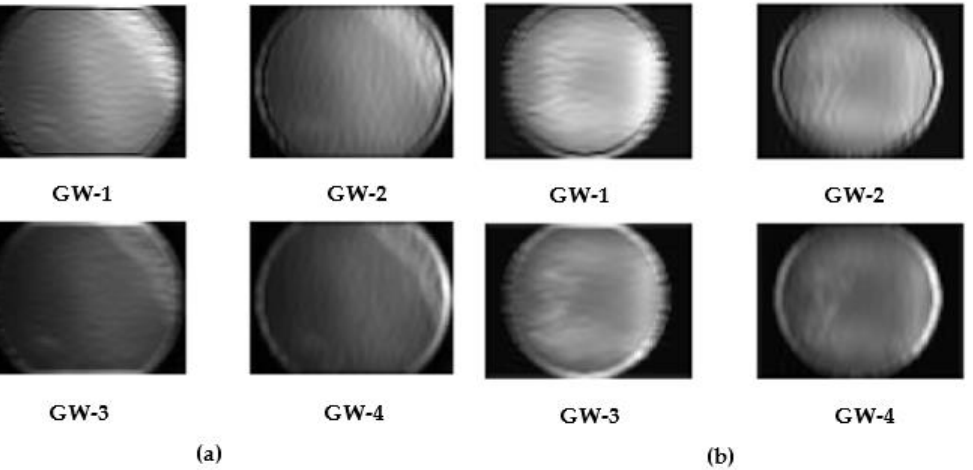
Figure 3. Samples of the generated GW images for both classes of the ROP dataset, ( a ) Diseased, ( b ) Not Diseased.